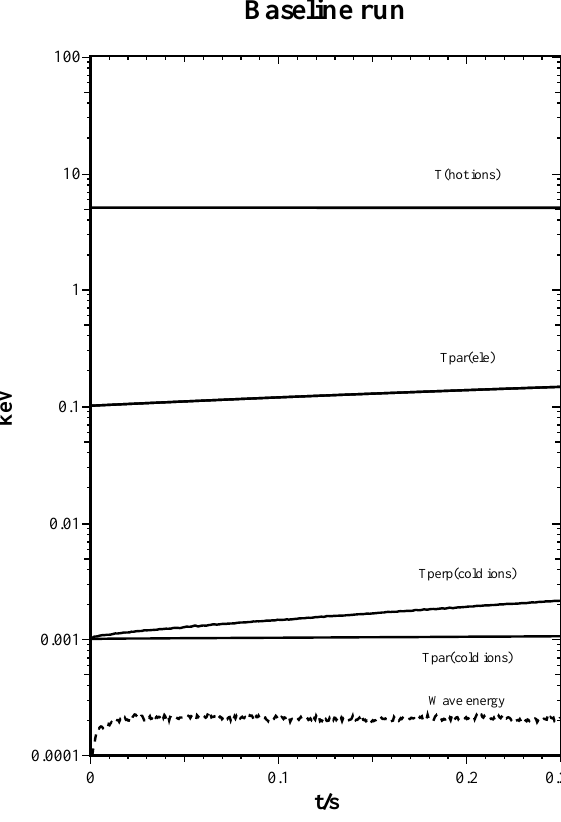
Fig. 11. Temporal power spectrum of perpendicular electric field E x fluctuations averaged over all z in baseline (dashed) and shell distribution runs (solid). Some proton cyclotron harmonic multiples are denoted by dotted vertical lines.